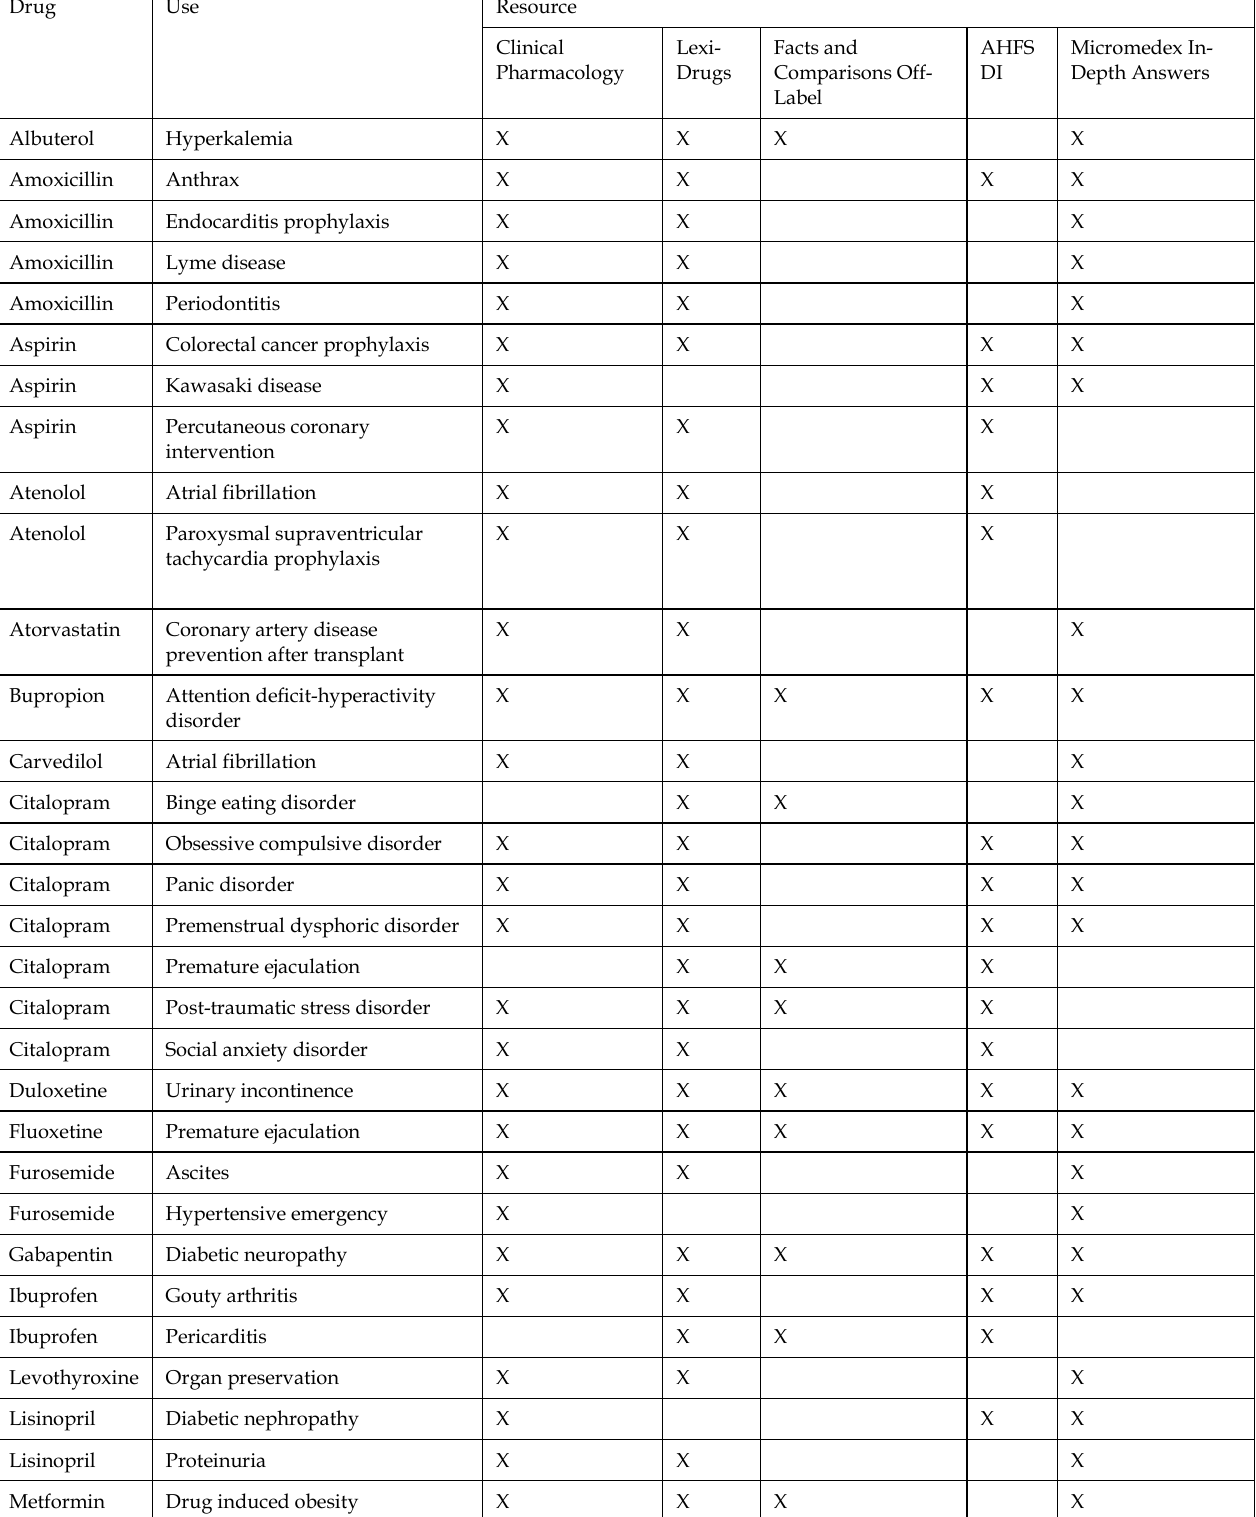
Table 1 Uses Analyzed for Completeness and Consistency Drug Use Resource